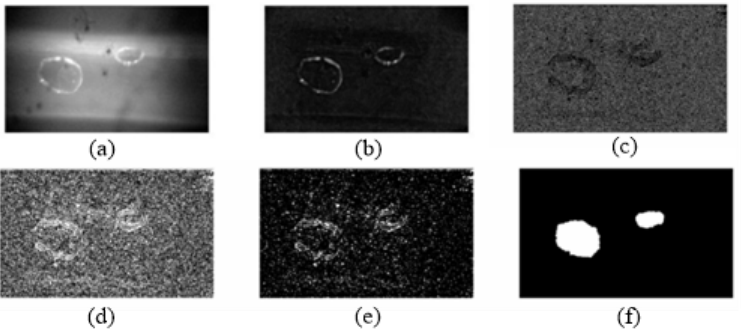
Figure 4. The processing of the bubble image. ( a ) Original image. ( b ) Background removed and brightness enhanced. ( c ) Edge detection. ( d ) Mathematical morphology expansion. ( e ) Mathematical morphology corrosion. ( f ) Bubble-edge-detection results.